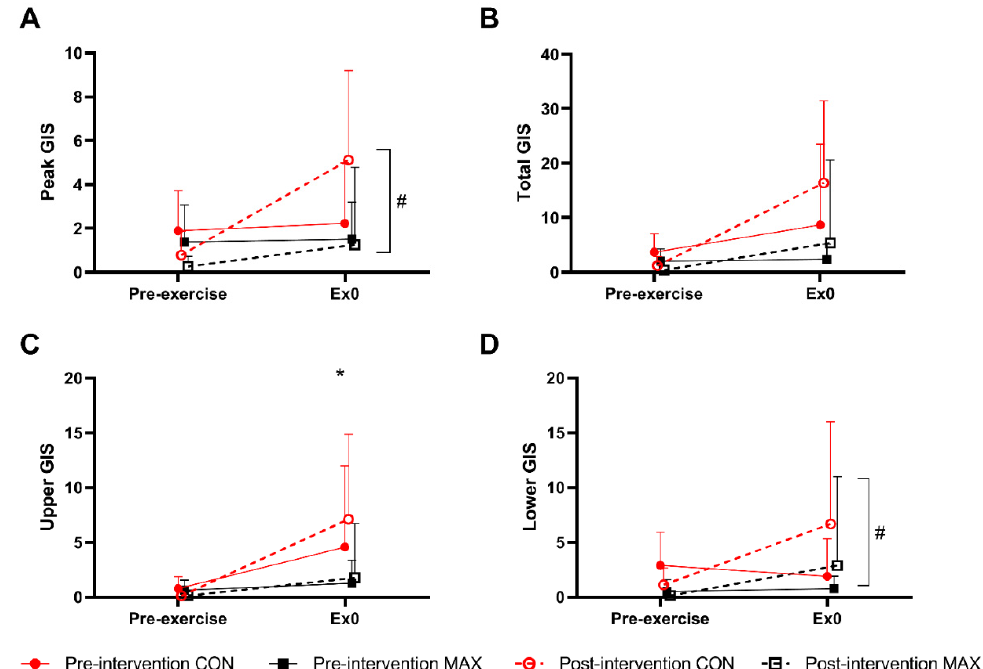
Figure 6. ( A ) Peak, ( B ) total, ( C ) upper, and ( D ) lower gastrointestinal symptoms (GIS) during a 35 km race in highly trained marathon runners before (pre-intervention) and after (post-intervention) a protocol to increase endogenous and exogenous CHO availability (MAX) compared with a control condition (CON) involving moderate CHO availability. Data are presented as means and standard deviations of the summative score for each GIS. * Represents a significant difference between the CON and MAX groups # Indicates a significant difference between pre-intervention and post-intervention .